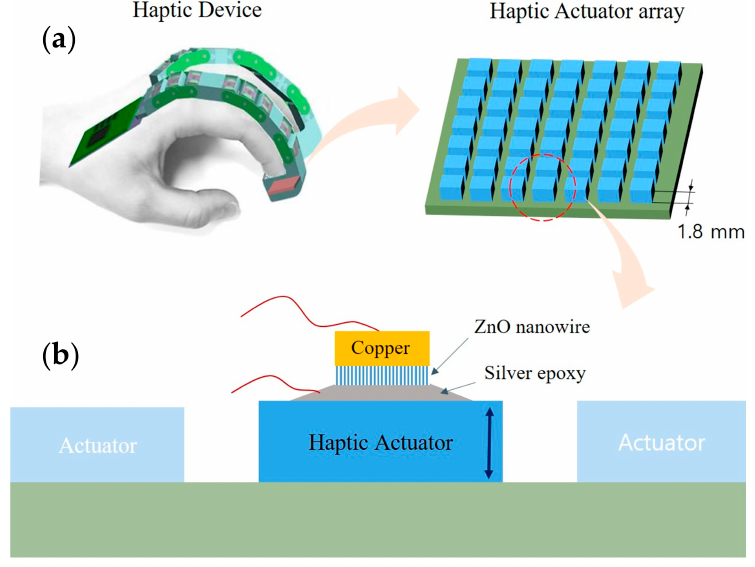
Figure 1. Concept of a miniaturized ZnO NW accelerometer: ( a ) Haptic device for a simulator and the haptic actuator array; ( b ) Miniaturized ZnO NW accelerometer attached on the cell of the haptic actuator array.